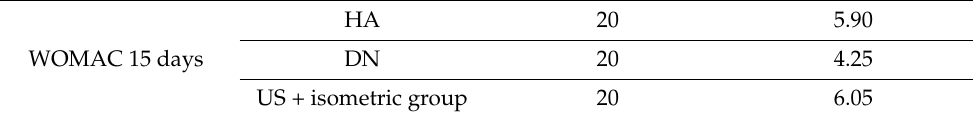
Table 7. WOMAC 15 days. Difference DN group vs. HA group and US + isometric group.